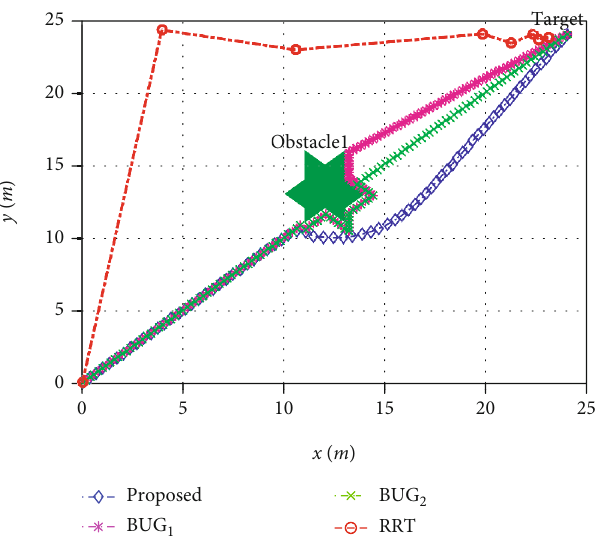
Table 1: The simulation parameters in Figures 8 – 10.